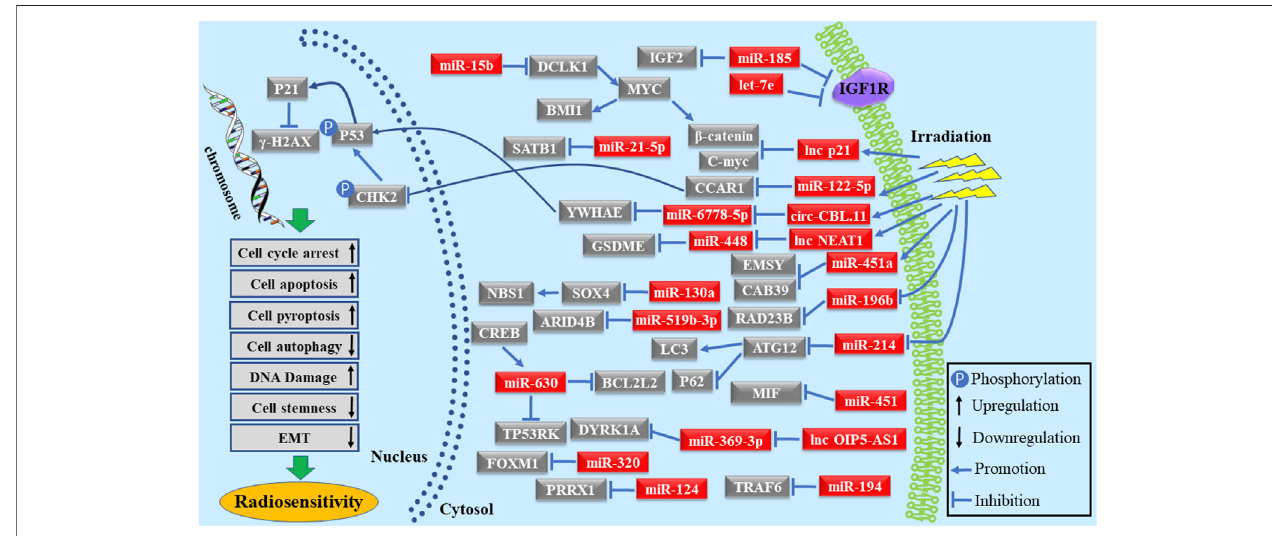
FIGURE 1 | Schematic diagram of ncRNAs as radiosensitivity enhancers in gastrointestinal carcinoma.